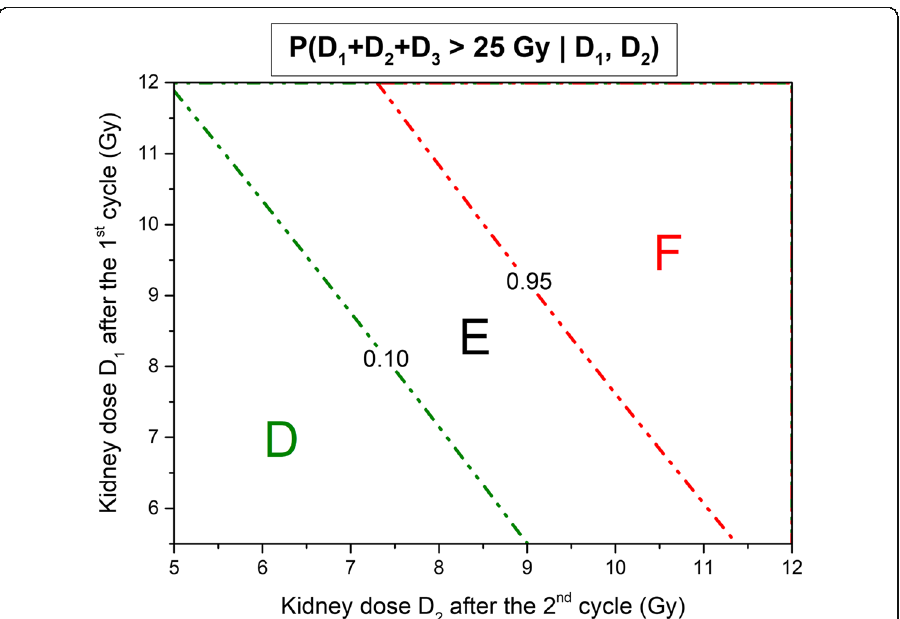
Fig. 6 Probability contour plots to exceed 25 Gy after three treatment cycles in function of D 1 , D 2 . Legend: Probability contour plots of D